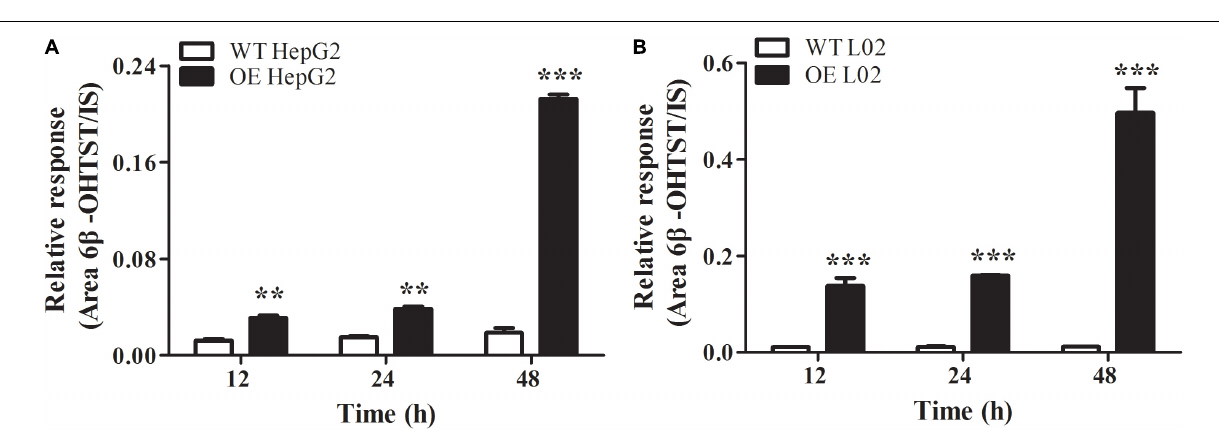
Frontiers in Pharmacology |